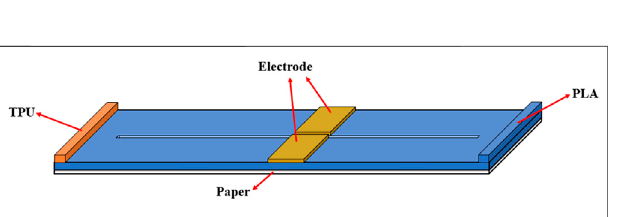
FIGURE 11 | Crawling robot with two feet with different friction coef fi